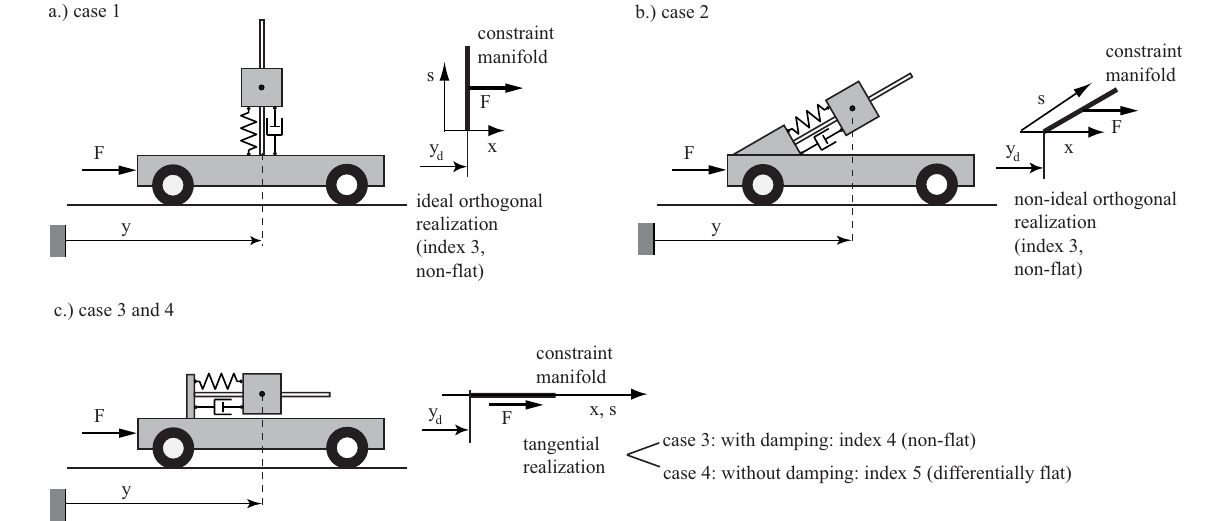
Figure 5. Possible situations arising in servo-constraint problems.